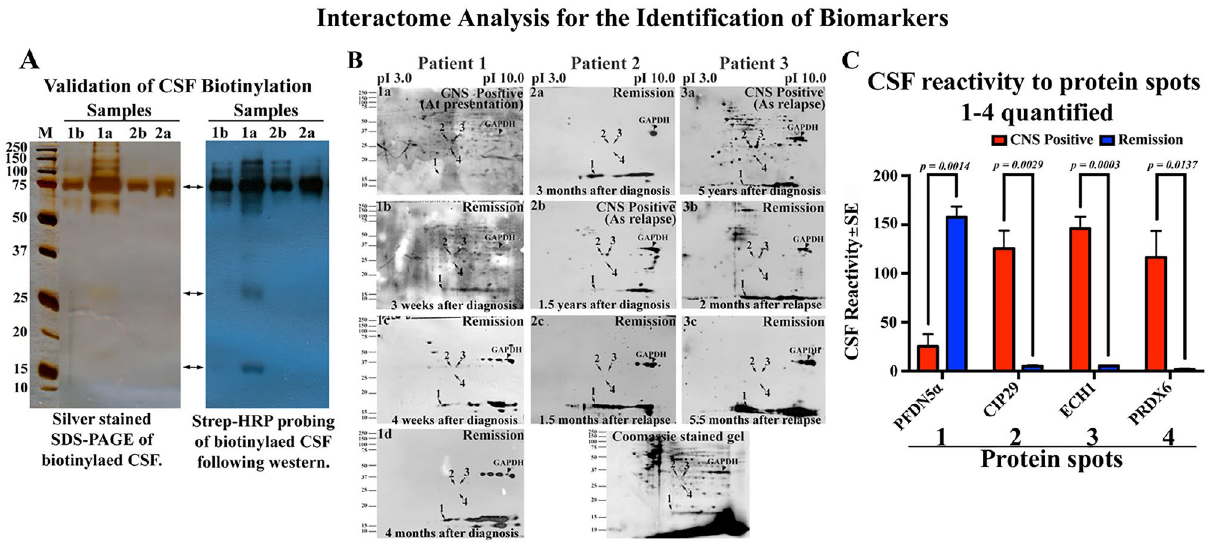
Figure 1. Identification of specific CNS +ve and −ve B-ALL CSF reactivity to lymphoblastic proteins using 2D far-western interactome analysis. ( A ) Validation of the extent of biotinylation of CSF proteins using 1 µg (left panel) or 0.25 µg (right panel) of CSF samples from patients 1 and 2 resolved in 12% SDS-PAGE. Despite the difference in the quantity of protein load, the streptavidin-HRP probed patterns on the blot (right panel) were similar (double headed arrows) to that of silver stained gel (left panel) indicating that the silver stained biotinylated proteins in the gel when probed with streptavidin-HRP were getting visualized on the blot highlighting the sensitivity following biotinylation and the advantage of small quantity of sample for performing far-western. ( B ) Pre B-ALL cell line (JM-1) protein lysate was prepared to obtain the proteomic profile of B-ALL proteins by two dimensional SDS-PAGE profiling and western blotting onto PVDF membrane. Far-western analysis was performed by probing profiled on PVDF membrane with biotinylated CSF samples from CNS +ve and −ve (remission) patients. The CSF reactivity pattern of sequential CSF samples (a–d) from the same patient from CNS +ve (at presentation or relapse) and CNS −ve (remission) from different time points were compared among and between patients 1–3. The protein spots that are common and unique which showed differential CSF reactivity in a consistent way in CNS +ve and −ve cases are marked with arrows (spots 1–4). Consistently CSF reacting protein spots 1–4 were selected for mass spectrometric analysis from the corresponding coommassie stained gel ( A ) to decipher the protein identity. The internal control GAPDH is shown by arrowheads. ( C ) Quantified CSF reactivity on the 2D blot (values of spots in 1a, 2b and 3a for CNS +ve and 1d, 2c and 3c for CNS −ve; n = 3) were found to be significantly different between CNS +ve and −ve cases. The protein identity of spots 1–4 was found to be PFDN5α, CIP29, ECH1 and PRDX6 respectively (Table